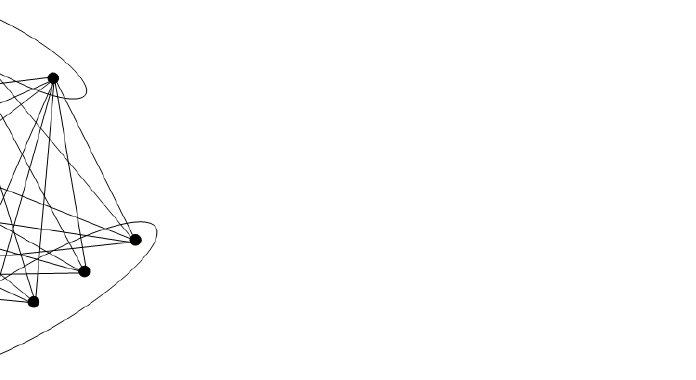
Figure 4. The complete multipartite graph K 2,3,5 with the fault-tolerant metric generator (all